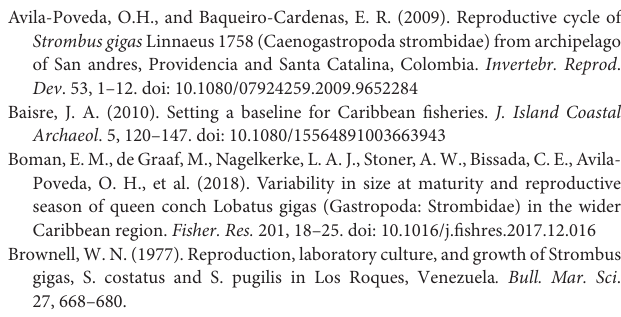
Supplementary Figure 1 | A. gigas average density (ind. ha − 1 ) by site (Juveniles and Adults) on Serrana Bank in the Seaflower Biosphere Reserve 2003–2013. Supplementary Figure 2 | Adults density (ind. ha − 1 ) on Serrana Bank (2003–2013) using kriging prediction. Supplementary Figure 3 | Juveniles density (ind. ha − 1 ) on Serrana Bank (2003–2013) using kriging prediction. Supplementary Table 1 | Total, juveniles and adults densities by sites, coordinates, depth and bottoms types on Serrana Bank